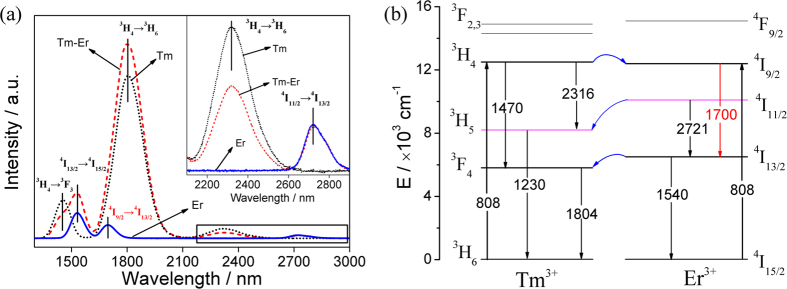
(a) The IR fluorescence spectra under the excitation of 808 nm and (b) energy transfer scheme of 65GeS2–25In2S3–10CsI glasses with the various doping behavior of Er3+-, Tm3+-, and Tm3+-Er3+.